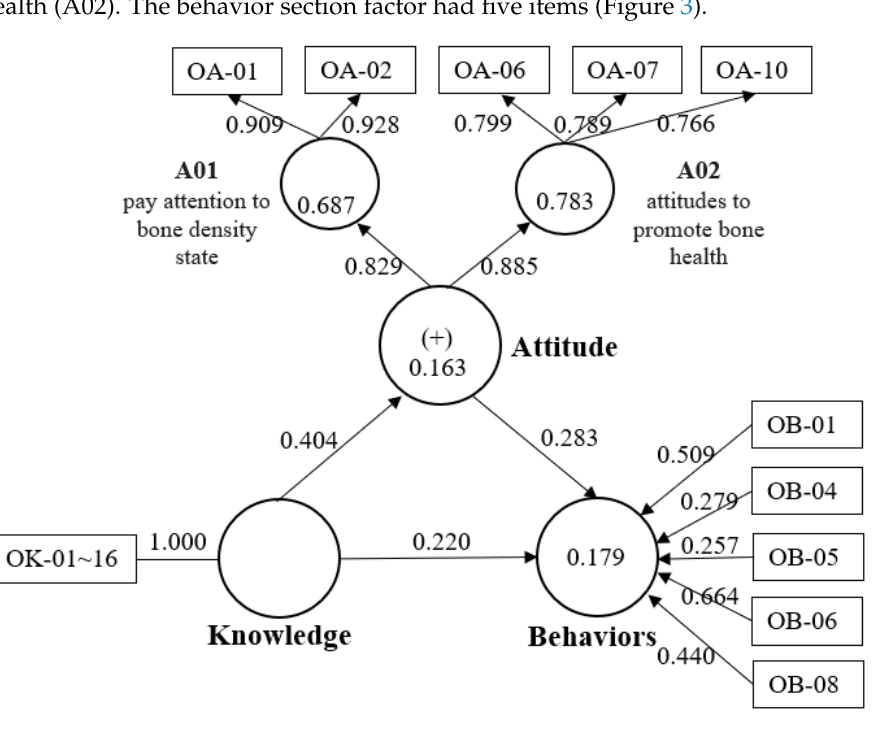
Figure 3. Path model of the OKHBQ using SmartPLS.